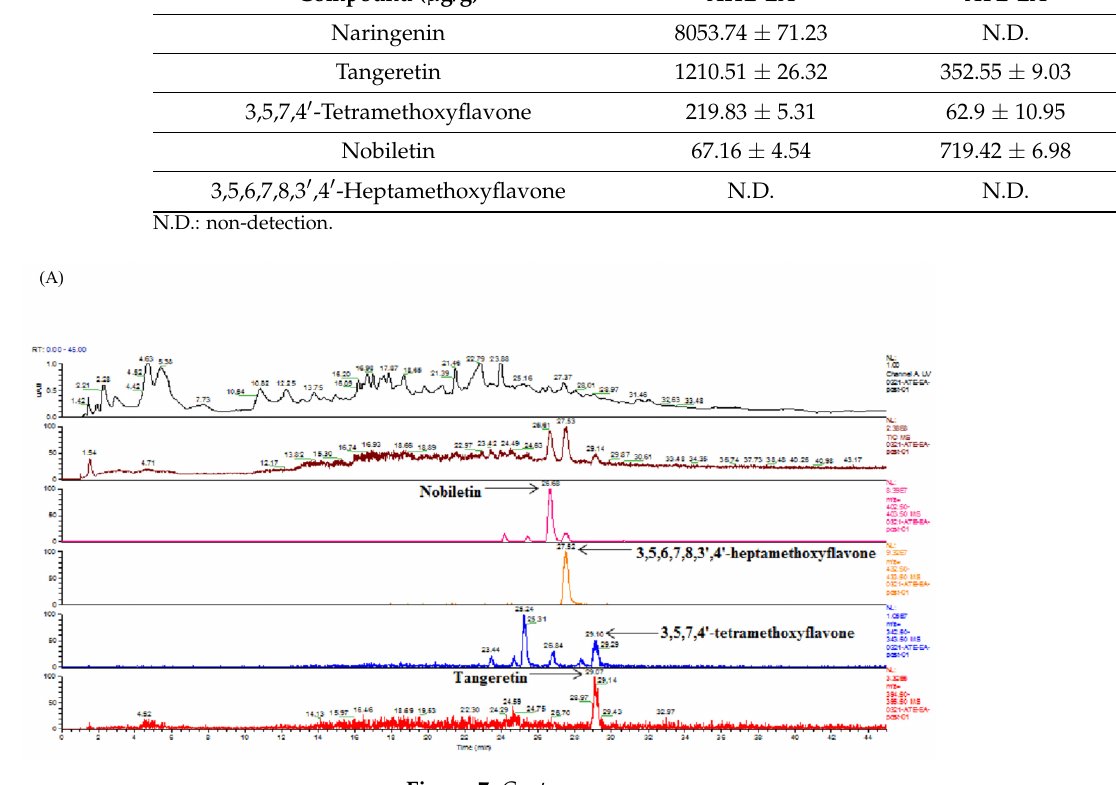
Figure 7. Total ion chromatogram of extracts from adlay ( A ) ATE-EA and ( B ) AHE-EA. 3.10. Analysis of Fatty Acid and Phytosterol of ATE-EA and AHE-EA by GC Table 5 shows the results of ATE-EA and AHE-EA analysis of fatty acids by gas chro- matography. Both main compounds were four fatty acids, namely, palmitic acid, linoleic acid, stearic acid, and oleic acid, of quantity in order. Phytosterol of ATE-EA and AHE- EA consisting of campesterol, stigmasterol, and β -sitosterol are shown in Table 6.